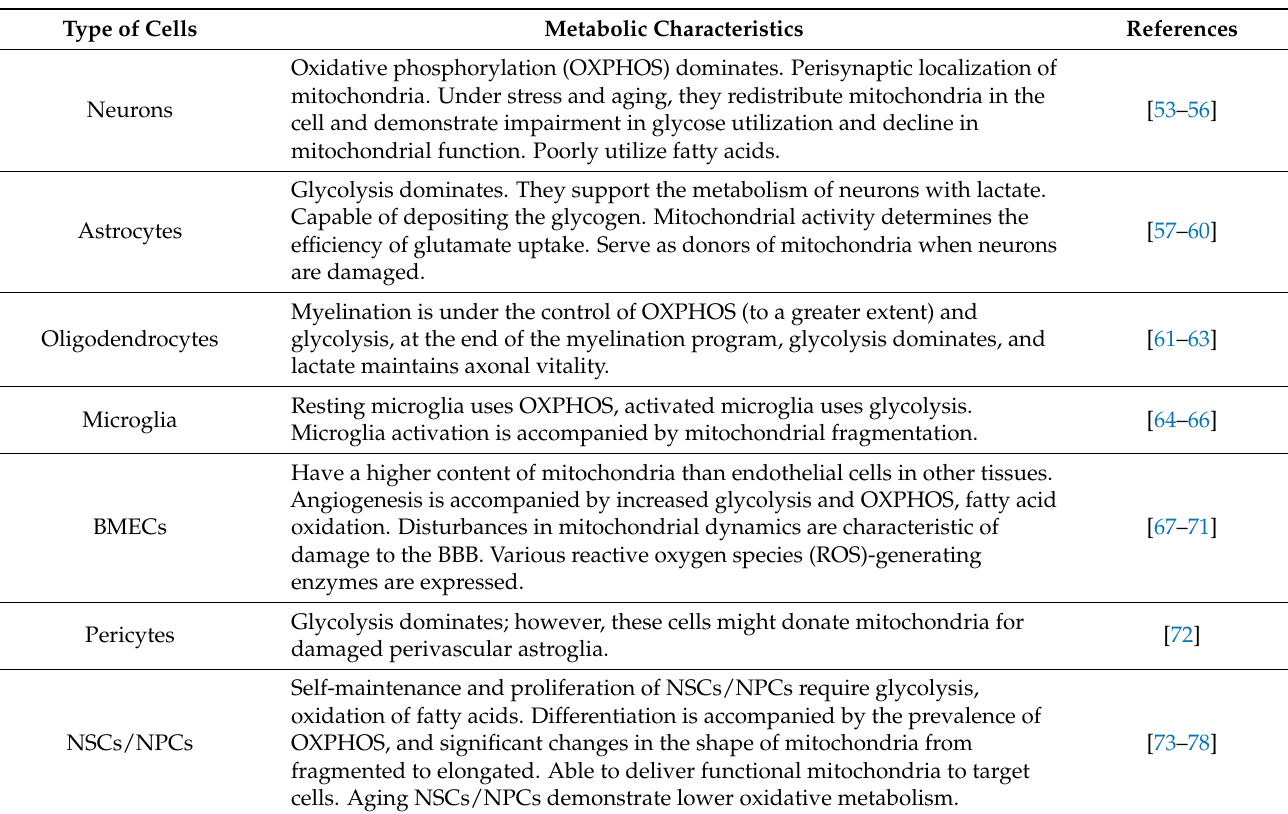
Table 1. Metabolic profile of brain